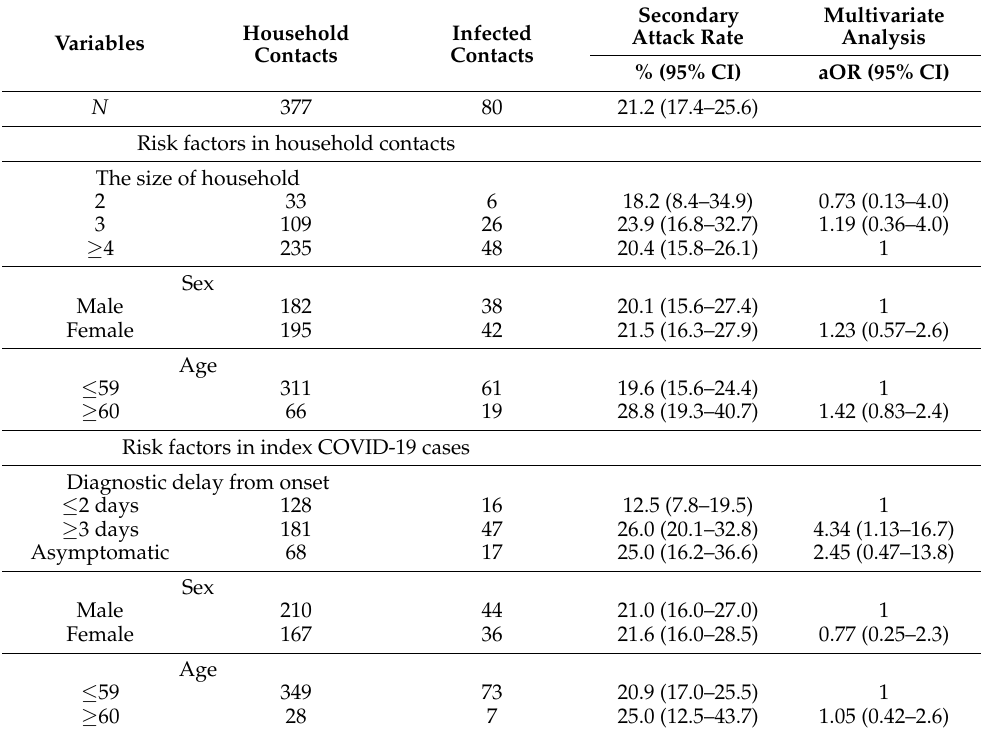
Table 3. Secondary attack rate among non-spousal household contacts.